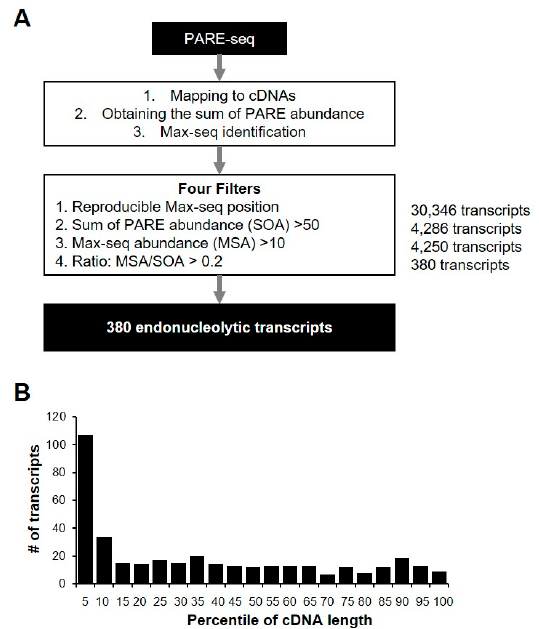
Figure 5. Identification of endonucleolytically cleaved transcripts. ( A ) Pipeline for the identification of endonucleolytically cleaved transcripts from PARE-seq libraries. All of the sequences from PARE-seq data were mapped to annotated cDNA and normalized. Endonucleolytically cleaved transcripts were identified using four filters. The number of transcripts passing each filter is indicated in bold (right); ( B ) relative coverage of each percentile of gene length for the 380 endonucleolytic cleavage sites. The number of transcripts was counted according to the endonucleolytic cleavage position for each percentile of cDNA length.